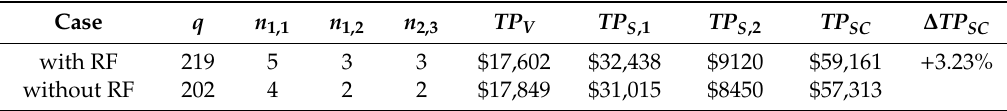
Table 2. Results of the numerical